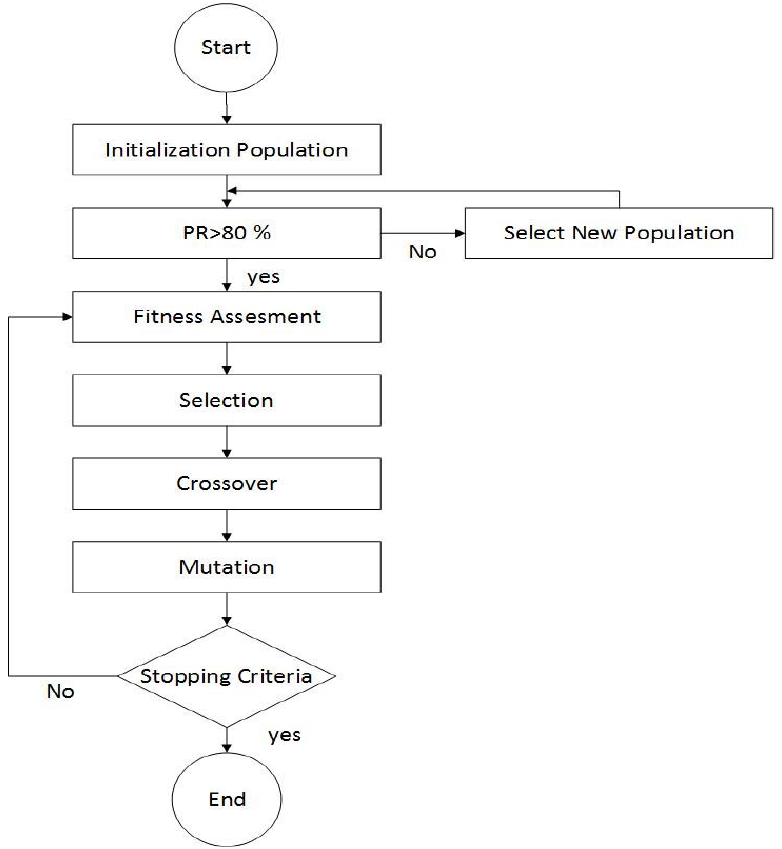
Figure 1. Flow Optimization process using Genetic Algorithm.